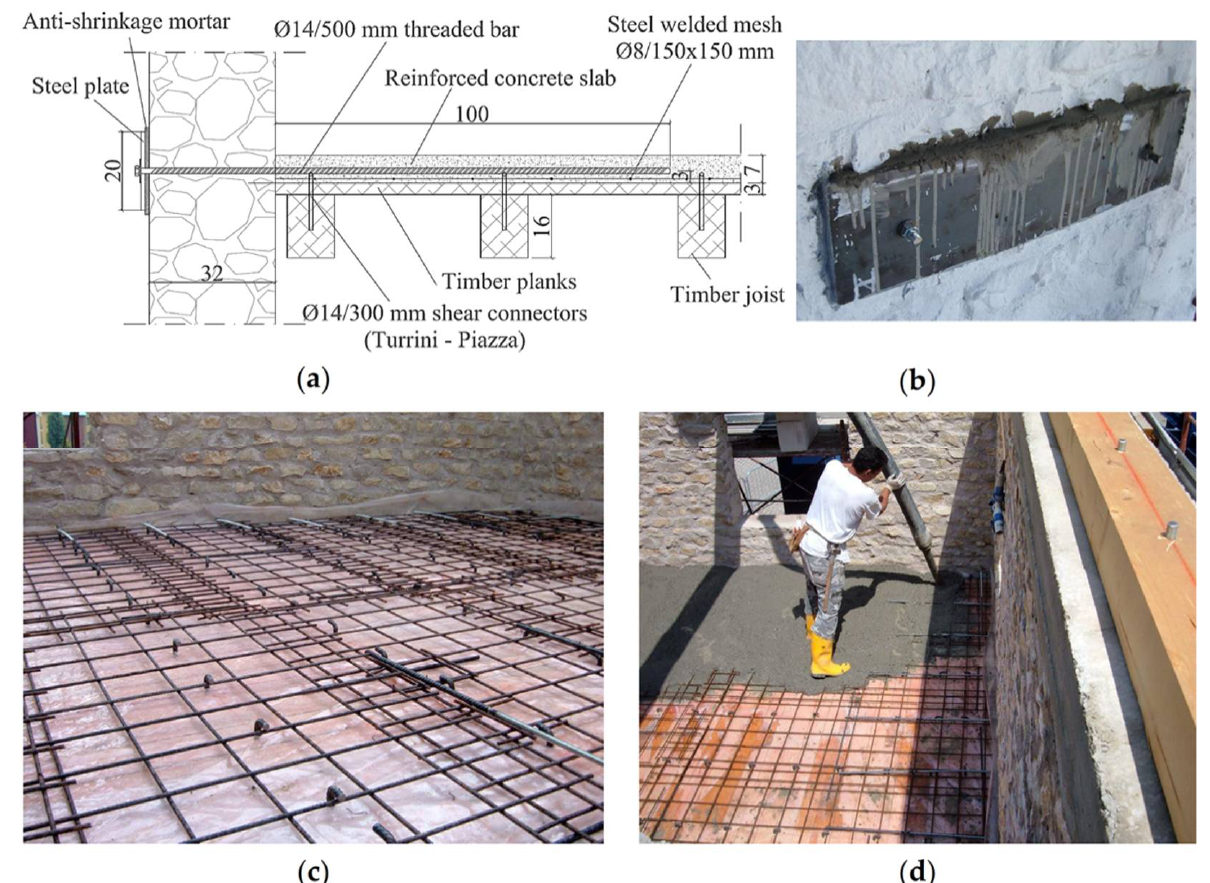
Figure 7. Building 3, retrofit at the first-floor level: ( a ) structural detail of the wall-to-diaphragm connection and of the RC slab; ( b ) external steel plates; ( c ) shear connectors, steel welded mesh and threaded bars for the wall-to-diaphragm connection; ( d ) lightweight RC slab casting. Units of cm.